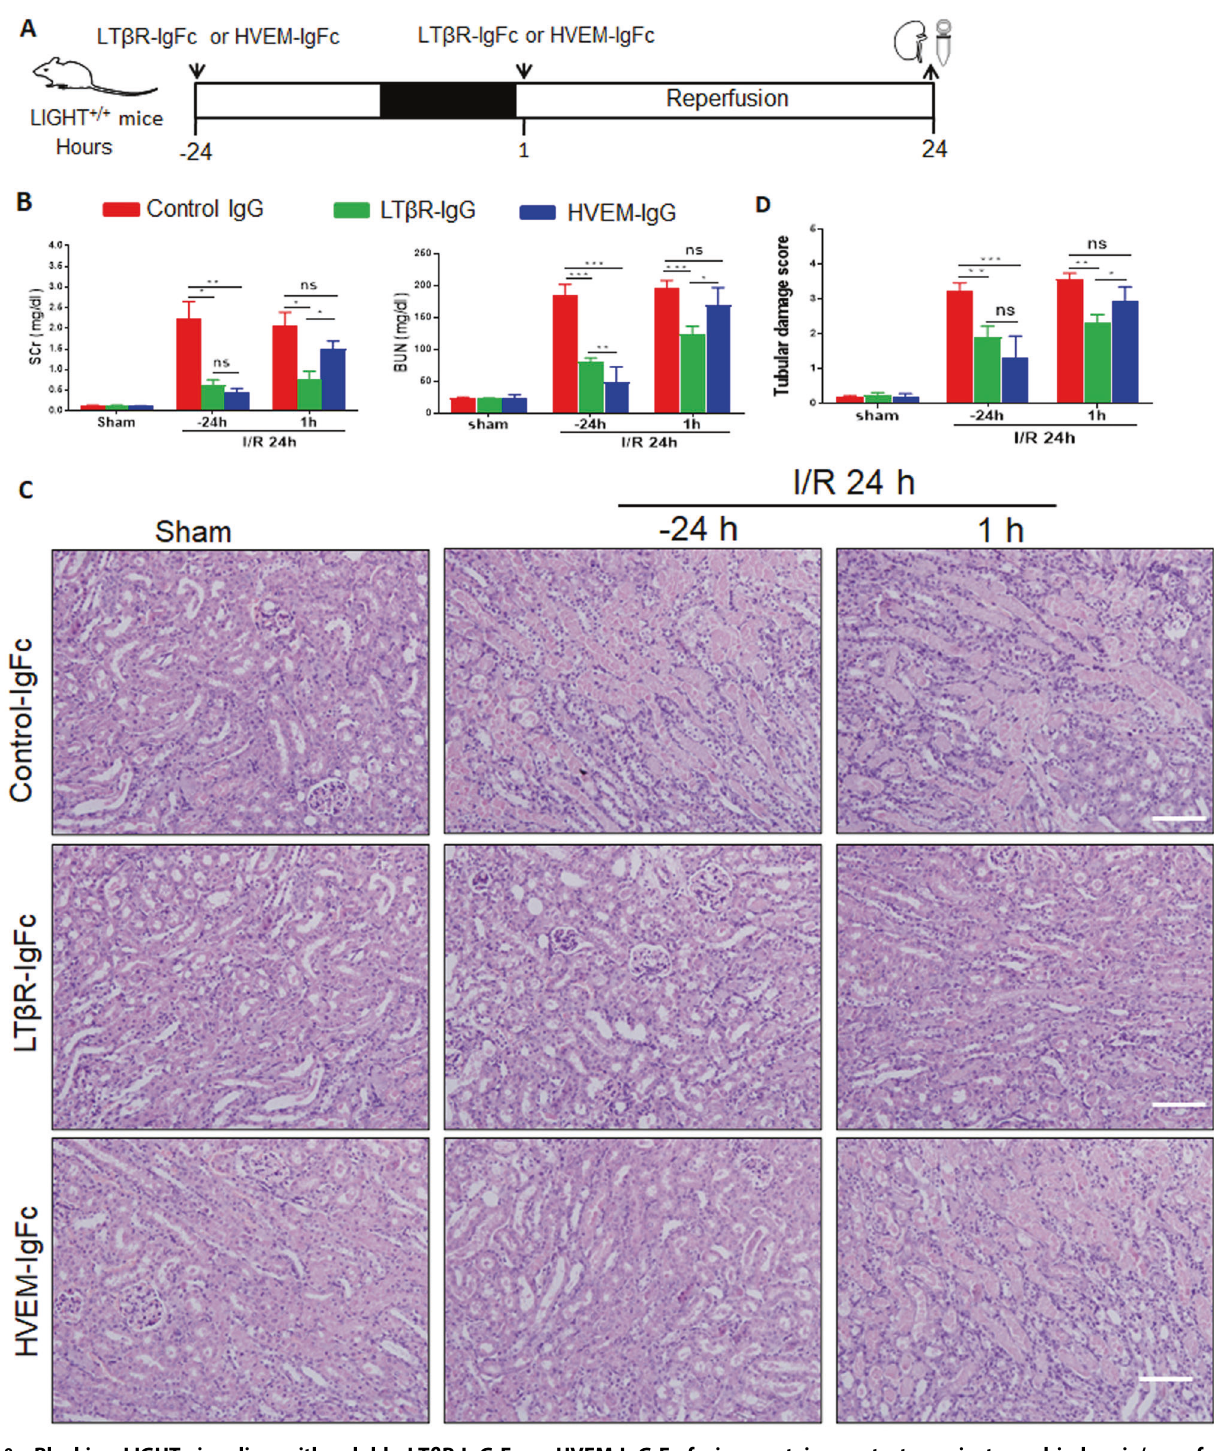
Fig. 8 Blocking LIGHT signaling with soluble LT β R-IgG-Fc or HVEM-IgG-Fc fusion proteins protects against renal ischemia/reperfusion injury in mice. LIGHT + / + mice pretreated with control IgG-Fc, soluble HVEM-IgG-Fc, or LT β R-IgG-Fc, followed by 35 min of renal ischemia and 24 h reperfusion. A A schematic graph for the procedures of I/R-AKI. B Measurement of serum Scr and BUN levels. C H&E staining for mice kidney sections. Scale bar, 50 μ m. D Quanti fi cation of pathological scores of tubular damages. Values are presented as mean ± SEM. Differences between the two groups were assessed with Student ’ s t test. ns, no signi fi cance, * p < 0.05; ** p < 0.01, *** p <